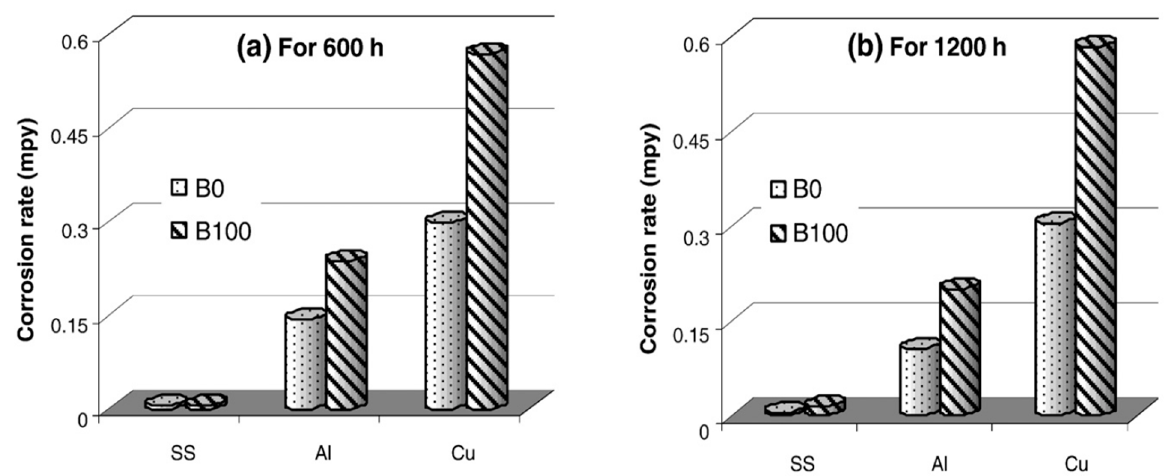
Figure 3. Corrosion rates of stainless steel (SS), aluminum (Al) and copper (Cu) [33].